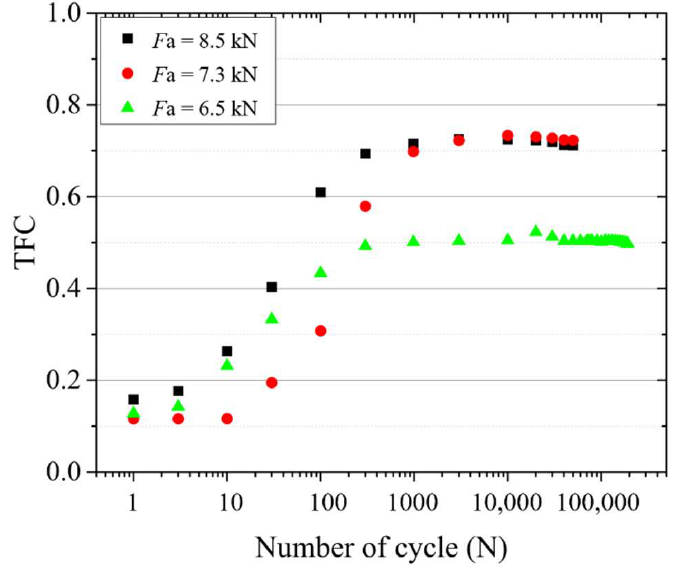
Figure 6. Evolution of TFC with the cycle number during the test.